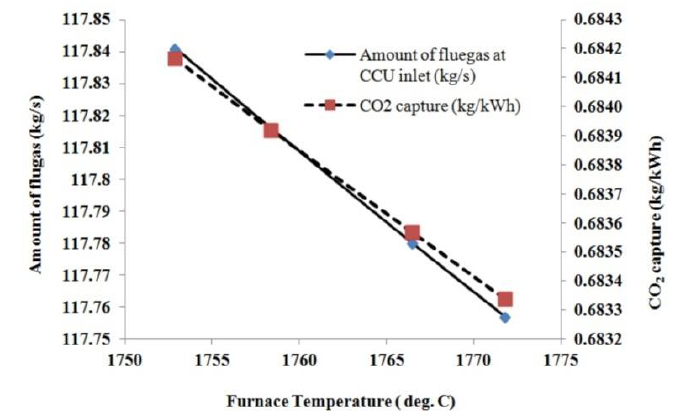
Figure 7. Environmental benefit of flue gas